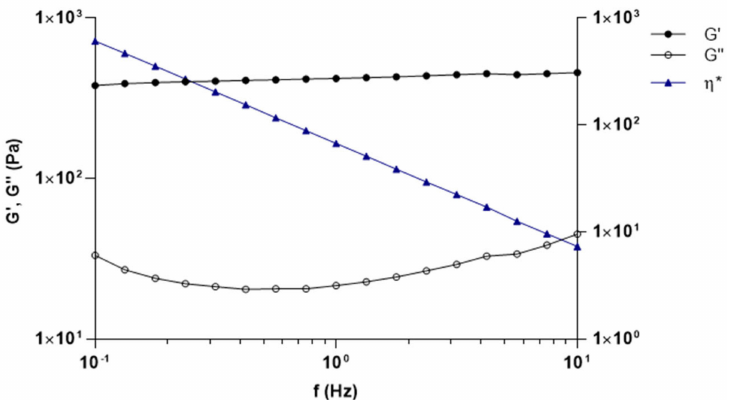
Figure 2. Creep and recovery test in Carbopol-based formulation containing capsaicin at different shear stress.